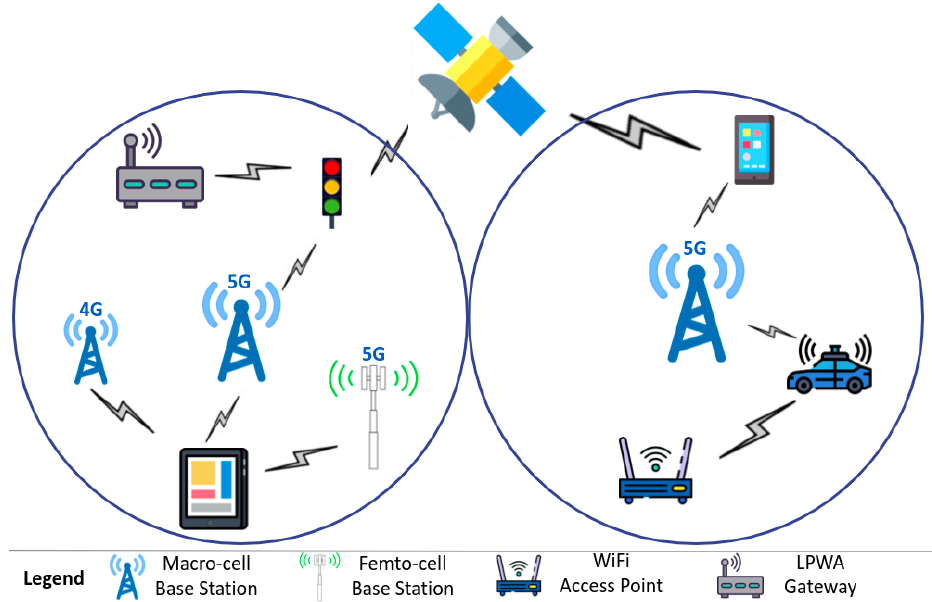
Figure 1. Presentation of different multi-connectivity scenarios for 5G Networks and